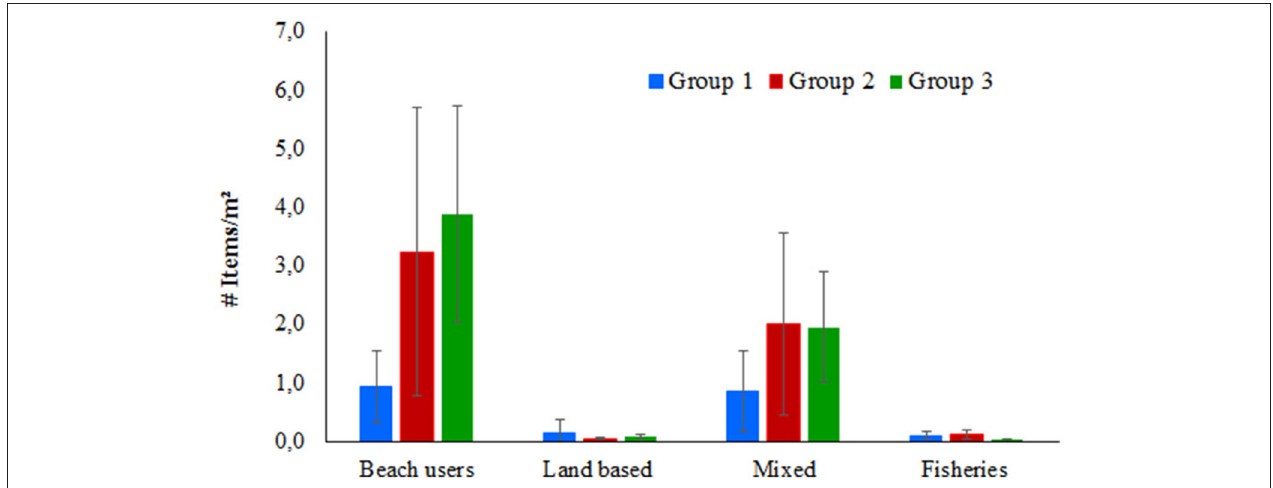
FIGURE 4 | Mean value of items according to their possible source evaluated in the three beach groups.